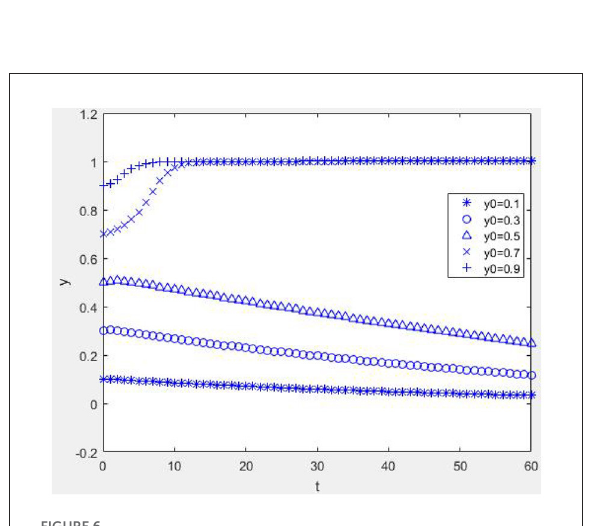
FIGURE6 Dynamic evolution diagram under Case 3( C R = 2.9).